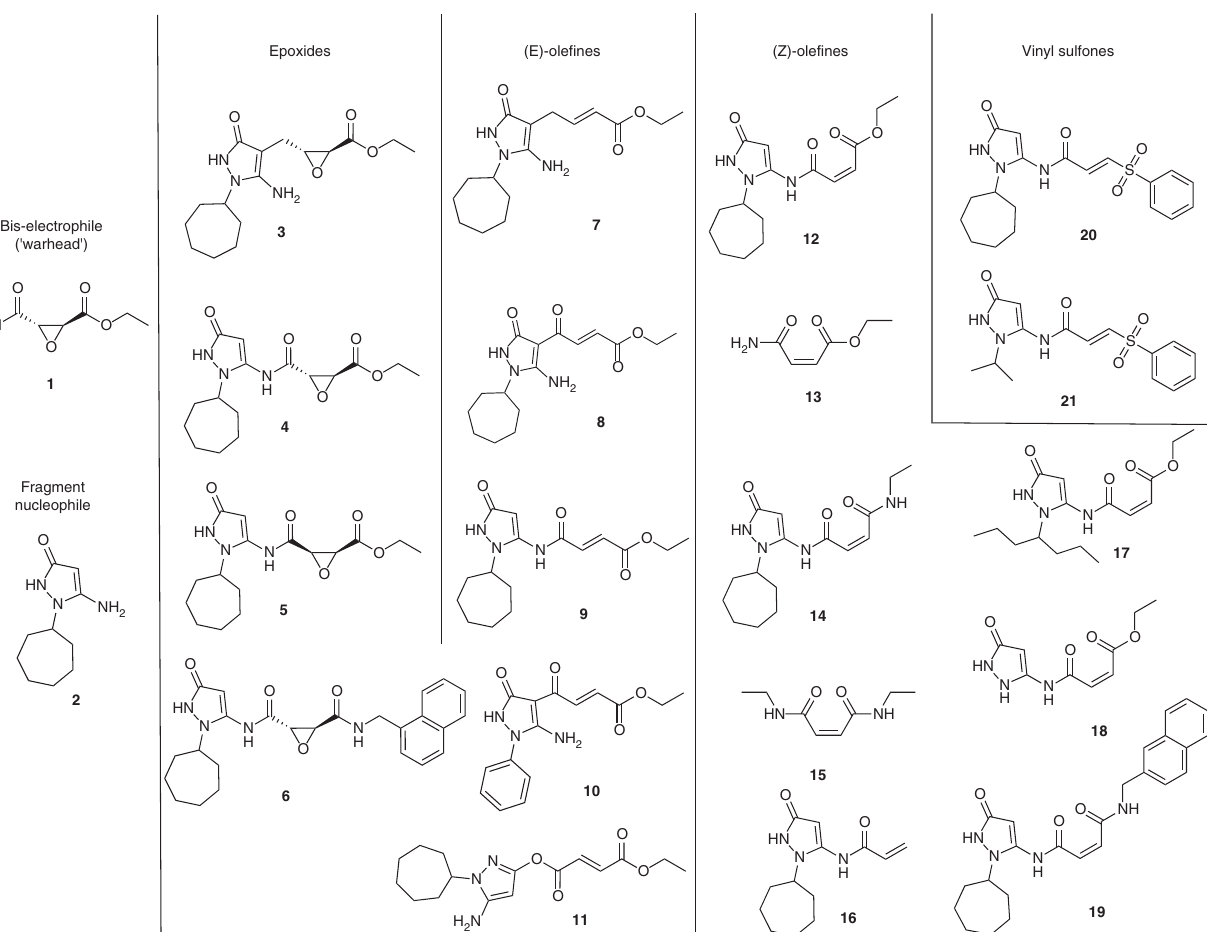
inhibitors 8 , 12 and 20 by hydrogen, N- isopropyl, N- phenyl or N-